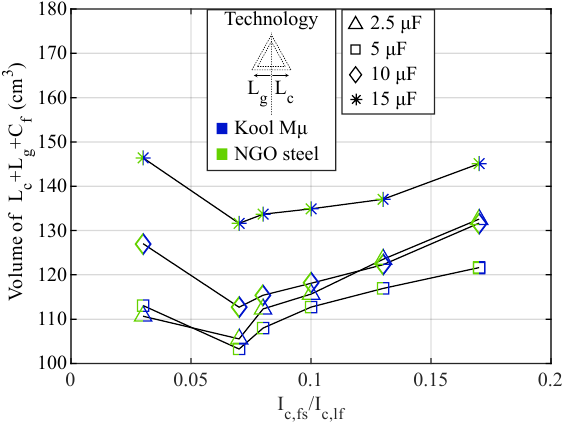
Figure 10. Total filter volume: L c + L g + C f , as a function of I c , f For the chosen operating point with C f = 5 µ F, the corresponding inductances are L g = 423 µ H and L c = 1.48 mH. The filter is designed to meet the IEC 61000-3-4 stan- dard with a safety margin of 2/3 of the maximum admissible harmonic amplitude, or ≈ I g I g , fs / , lf